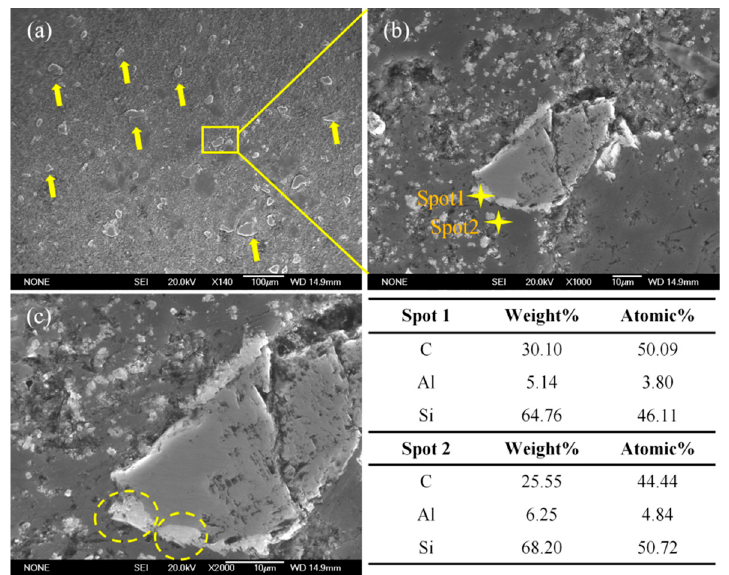
Figure 12. SEM images and EDS point scan analysis of Al-30Si-10C(G1)-5SiC: ( a ) 140 × SEM image, ( b ) 1000 × SEM image and EDS point scan analysis, and ( c ) 2000 × SEM